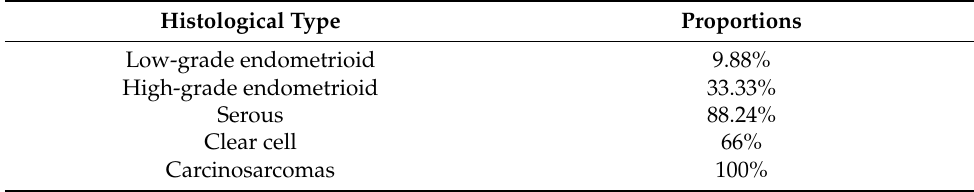
Table 5. Proportions of the different histological types mutated for p53 protein.